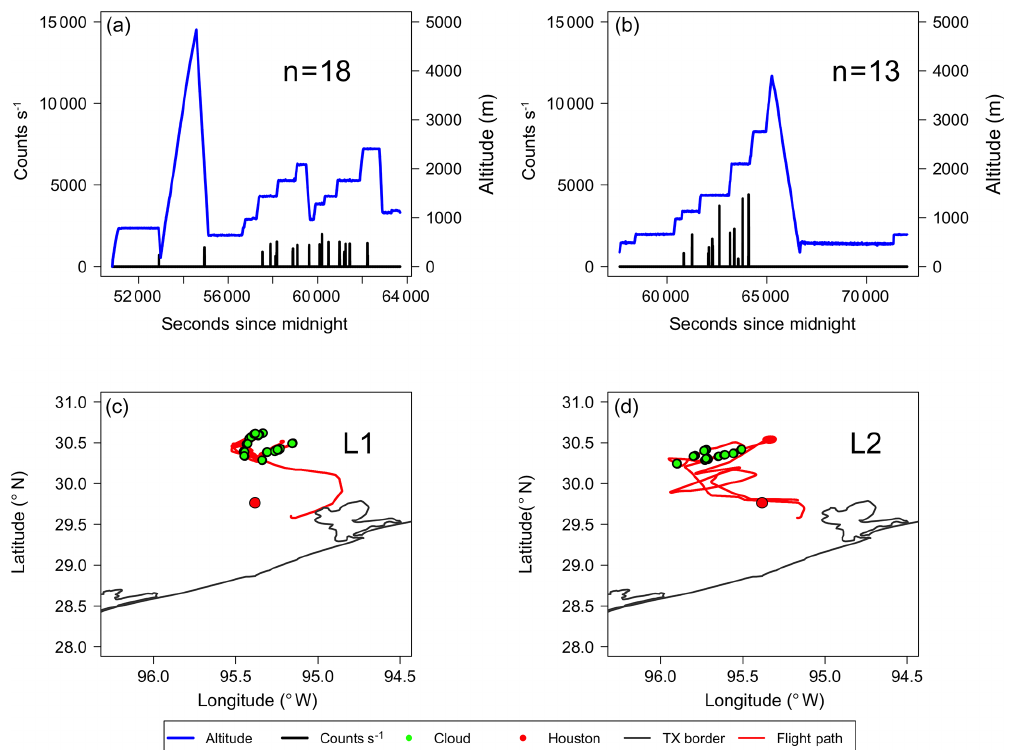
Figure 2. L1 and L2 are shown on the left and right, respectively. Flight altitude (blue) as a function of time is displayed in (a) and (b) , with droplet counts per second in black. The “ n = ” represents the number of clouds sampled for each flight after filtering. Panels (c) and (d) show the Texas coast in grey with the location of Houston represented by the red dot. The flight path is outlined in red with the location of clouds displayed by green dots. Table 4. The mean PCF, 85th percent quantile, and 15th percent quantile values for center data (on the left) and edge data (on the right) for L1, L2, H1, and H2 in Fig. 5, along with average low and high values from Fig. 9. Center data Edge